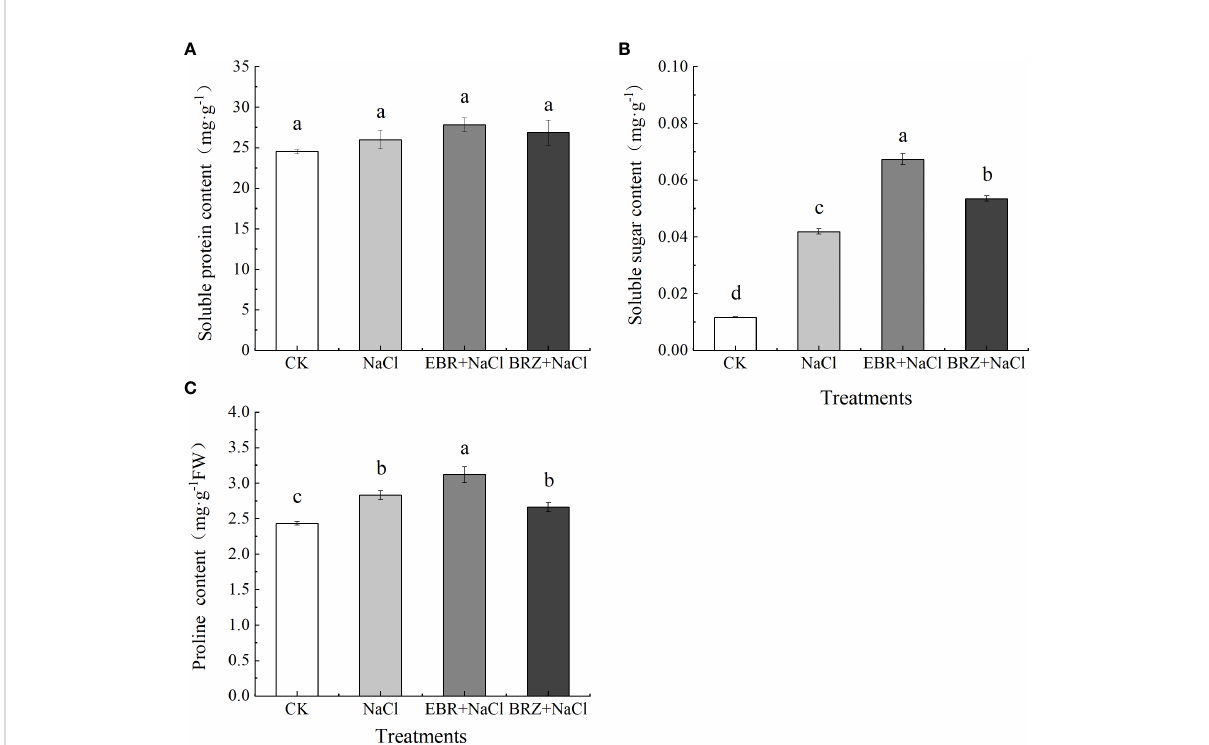
FIGURE 5 Effects of exogenous EBR on the contents of soluble sugar (A) , soluble protein (B) and proline (C) in leaves of cucumber seedlings under salt stress. Each value is the mean of three independent experiments, Data indicate the mean ± SE ( n = 3). Signi fi cances were tested within the same day by one-way ANOVA. Different letters indicate signi fi cant differences ( P < 0.05).